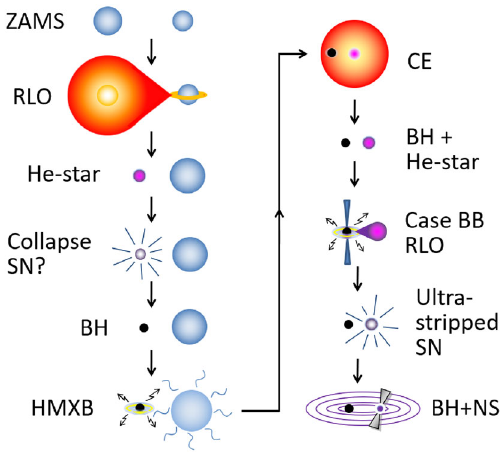
Fig. 9 Illustration of the formation of a tight BH ? NS binary that evolves towards a merger. See Figs. 6 and 7 for explanation of acronyms. Image reproduced with permission from Tauris and van den Heuvel (2023), copyright by